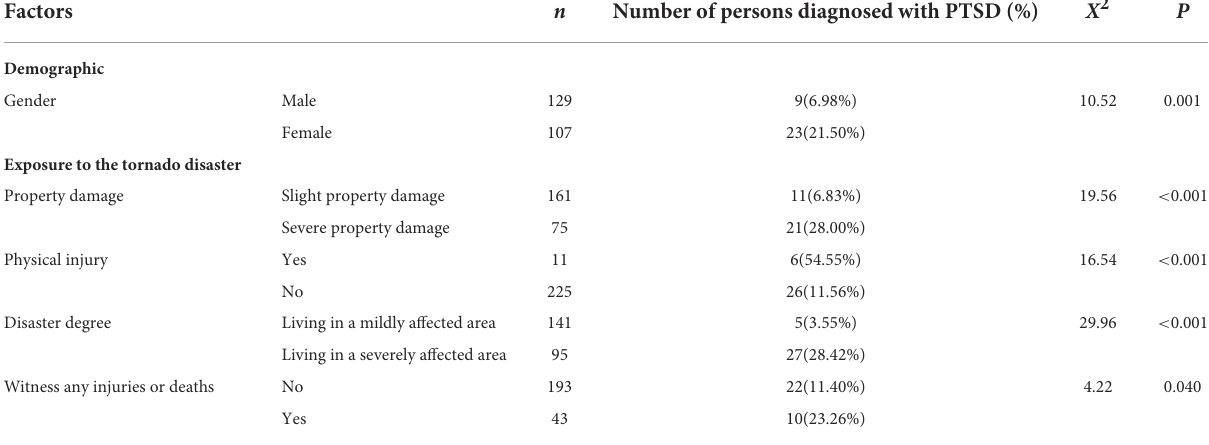
TABLE 3 Results of the chi-square test on collected factors in rural residents who survived the tornado disaster.